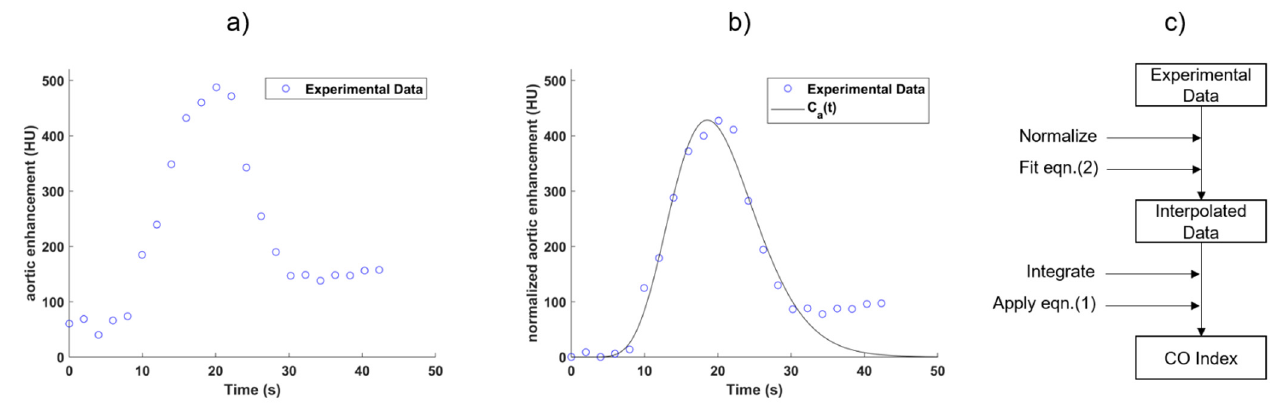
Figure 1. ( a ) The temporal change in aortic enhancement was monitored from dynamic CT imaging after an intravenous bolus injection of iodinated contrast solution. ( b ) The aortic time-enhancement curve C a (t) was obtained by fitting the experimental data acquired from CT with a modified gamma variate function (MGVF) followed by baseline subtraction. ( c ) Schematic illustration of derivation of the CO index from the experimental data and C a (t).